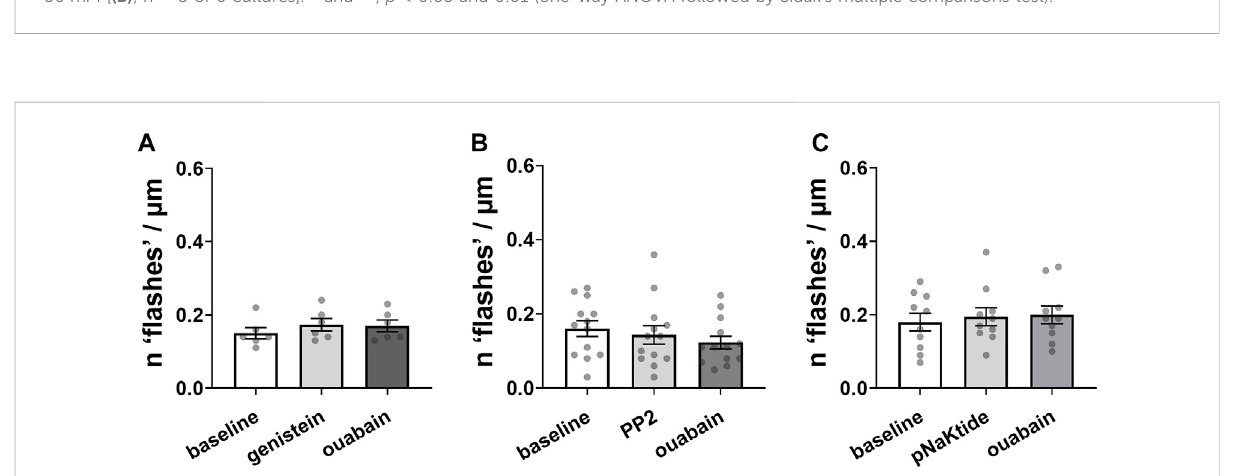
FIGURE 3 Ouabain-induced Ca 2+ fl ashes depend on Src kinase activation by phosphorylation. Inhibition of tyrosine phosphorylation by 50 µM genistein [ (A) ; n =6of3cultures]orinhibitionSrckinaseactivationwith10 µMPP2[ (B) ; n =13of7cultures]preventedCa 2+ fl ashesinducedby10 µMouabain. Ca 2+ fl ashes were also not seen in the presence of a speci fi c inhibitor of the Na,K-ATPase-dependent Src kinase activation, pNaKtide (1 µM) [ (C) ; n = 10 of 6 cultures]. The data are compared with a one-way ANOVA followed by Sidak ’ s multiple comparisons